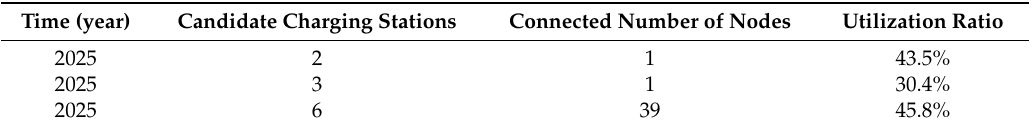
Table 11. Plan for the charging station.